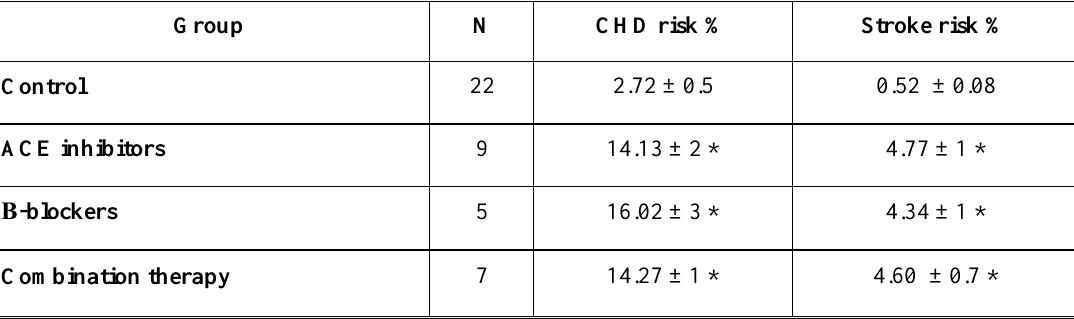
* P ≤ 0.05 significant difference from the